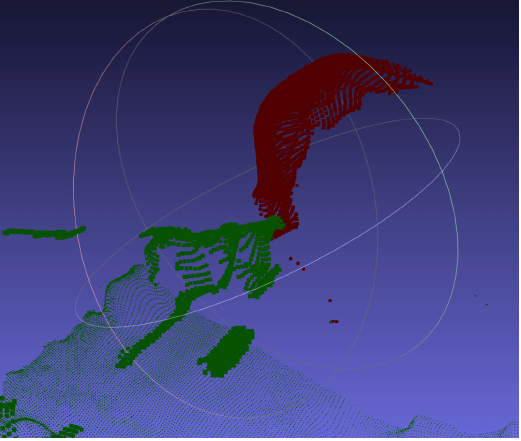
Figure 18. Greater detail is shown in the difference of the dots detected as part of basketball in color red and the tripod in color